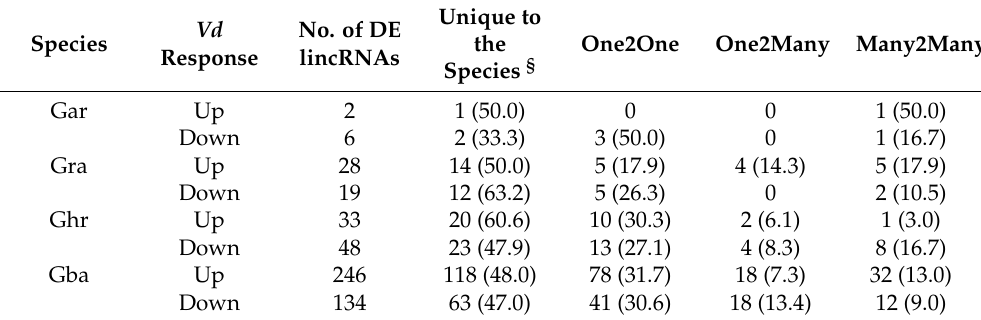
Table 2. Family classification of the stringently selected Vd -responsive